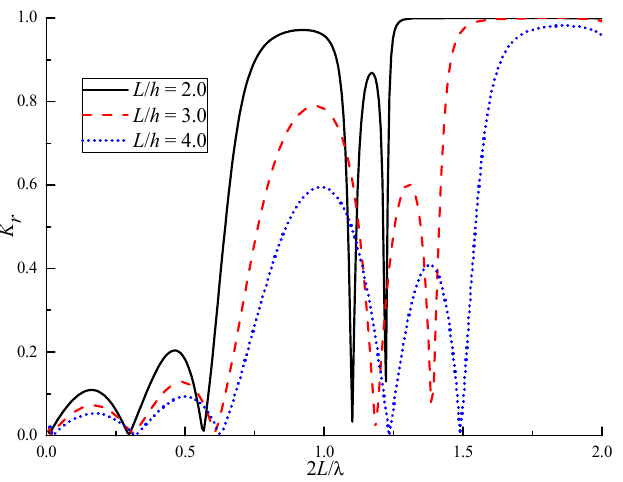
Figure 8. Reflection coefficient versus 2 L / λ under different spacings of plates ( N = 3 and d / h = 0.5). Table 3. Characteristics of Bragg reflection under different spacings of plates ( N = 3 and d / h = 0.5).